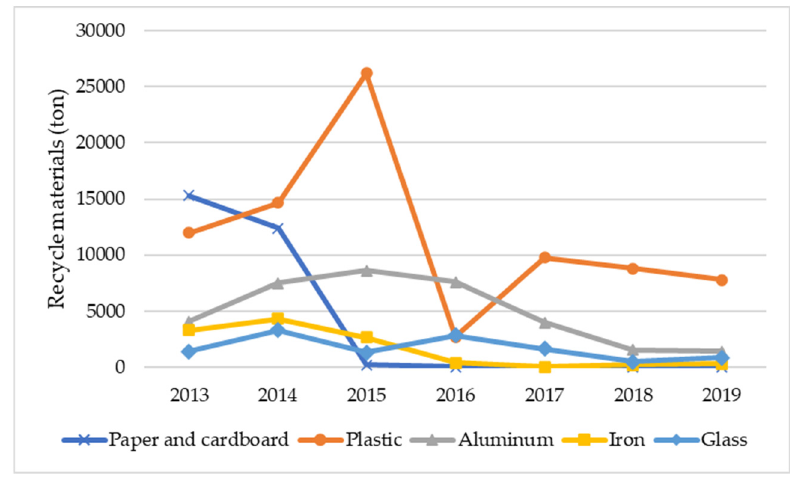
Figure 6. Recycled materials exported to other countries (adapted from [27]).